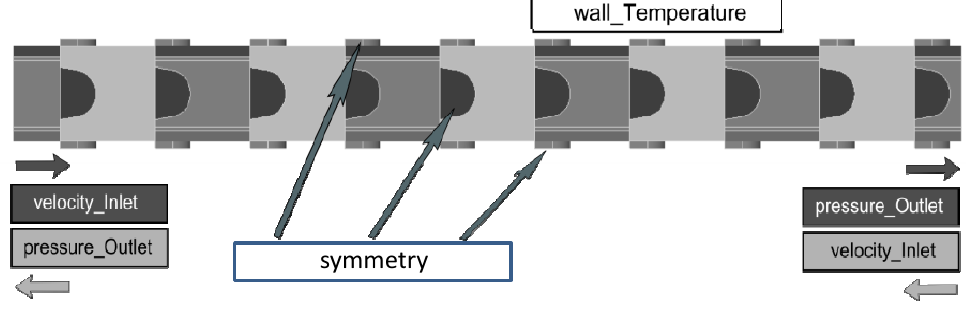
Figure 7. Computational domain and boundary conditions for the tube sample.